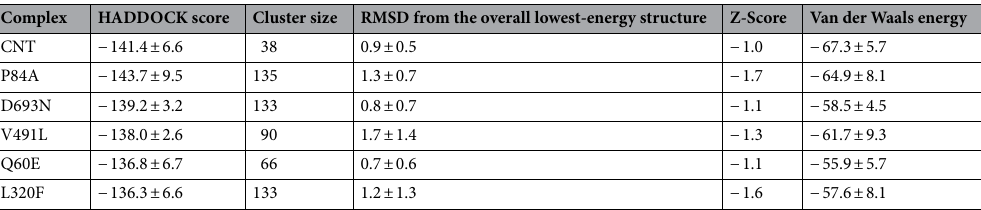
Table 2. Docking results of control complex (ACE2 and SARS-CoV2 spike protein) and top 5 docked molecules (different AC2 mutants and normal SARS-CoV-2 spike protein). Docking scores are represented by HADDOCK scores (the more negative docking scores, the better the binding affinity of two